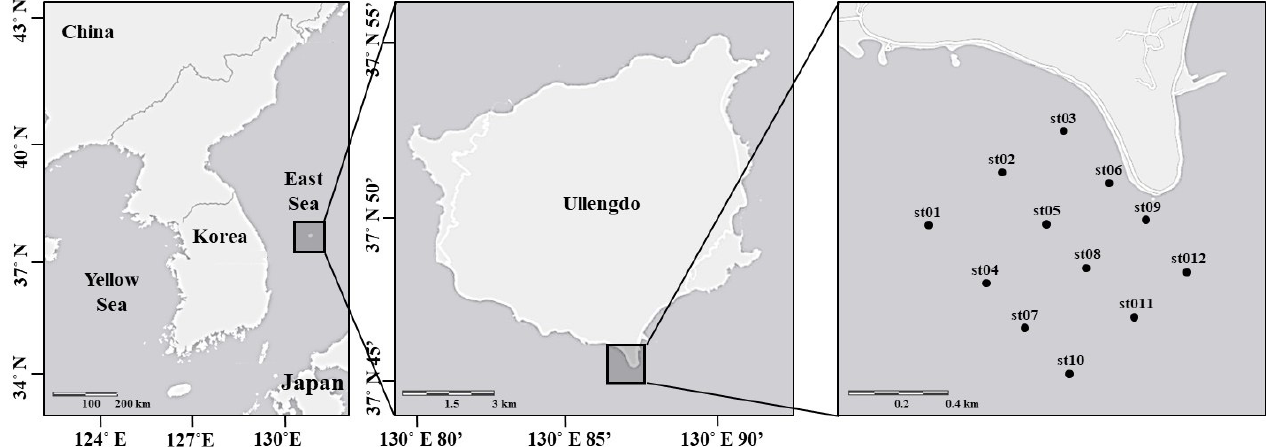
Figure 1. Sampling area at Ulleungdo in the East Sea.